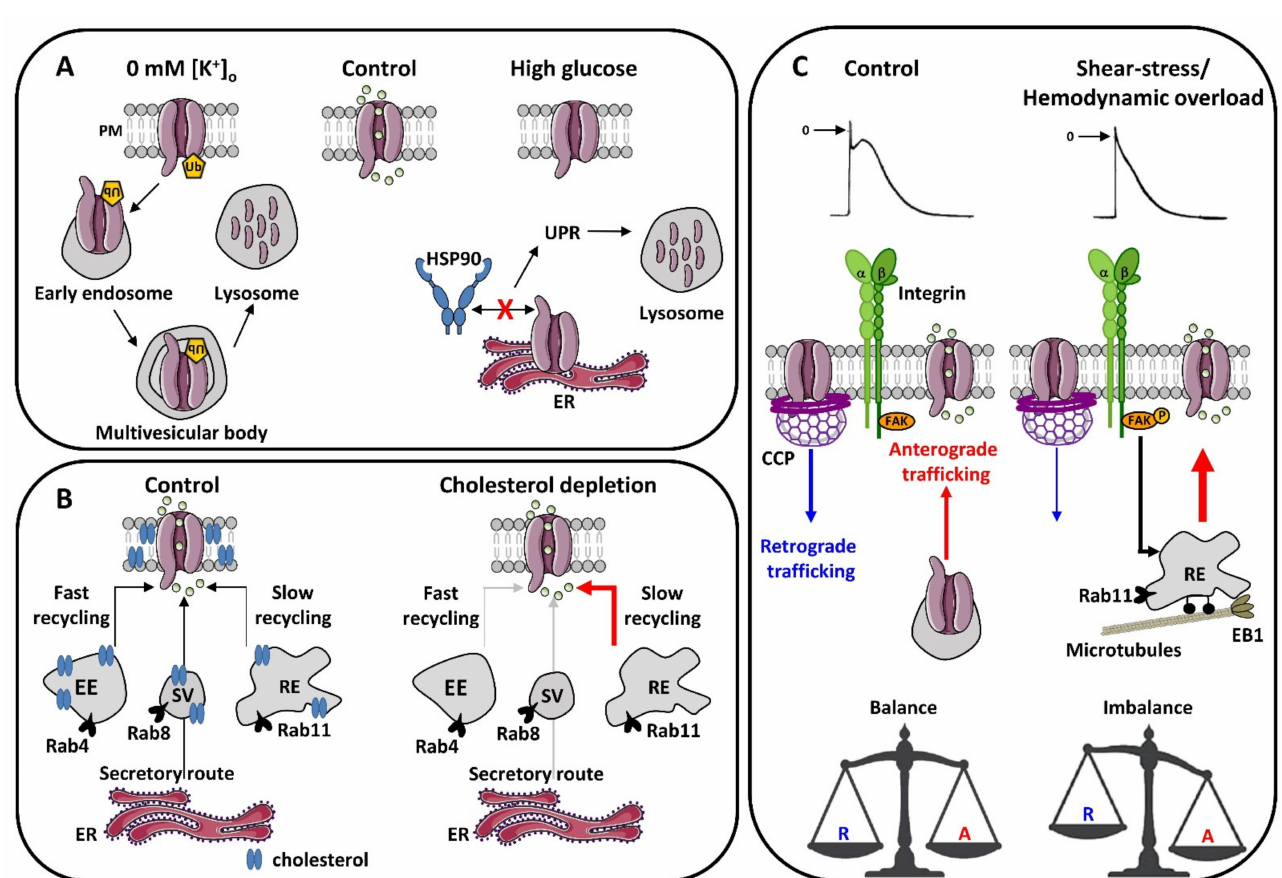
Figure 2. Summary diagram of alterations in the intracellular trafficking of cardiac potassium channels involved in acquired arrhythmias. ( A ) Regulation of hERG channel trafficking by hypokalemia and hyperglycemia. Decreased extracellular potassium triggers hERG channel ubiquitination, internalization, and degradation. Hyperglycemia interrupts the interaction between hERG and the chaperone HSP90 and prevents its anterograde trafficking to the membrane, activating the UPR and channel degradation. ( B ) Regulation of K V 1.5 trafficking by cholesterol. Cholesterol depletion activates the recycling and exocytosis of the K V 1.5 channel from the recycling endosome without affecting either the secretory route or the fast recycling pathway mediated by the early endosome. ( C ) Regulation of K V 1.5 trafficking by mechanical constraint and atrial remodeling. In control condition, both anterograde and retrograde pathways are at equilibrium. Laminar shear stress stimulates the integrin/phospho-FAK signaling, which activates the recycling of K V 1.5 channels accumulated in the recycling endosome. In remodeled atria and during AF, this recycling pathway is constitutively activated and the trafficking balance is altered in the direction of a favored anterograde traffic to the detriment of retrograde traffic. Abbreviations: A: anterograde; CCP: clathrin-coated pit (cleaved by dynamin); EB1: end-binding protein 1; EE: early endosome; ER: endoplasmic reticulum; FAK: focal adhesion kinase; HSP90: heat shock protein 90; P: phosphorylation; PM: plasma membrane; RE: recycling endosome; R: retrograde; SV: secretory vesicle; Ub: ubiquitylation; UPR: unfolded protein